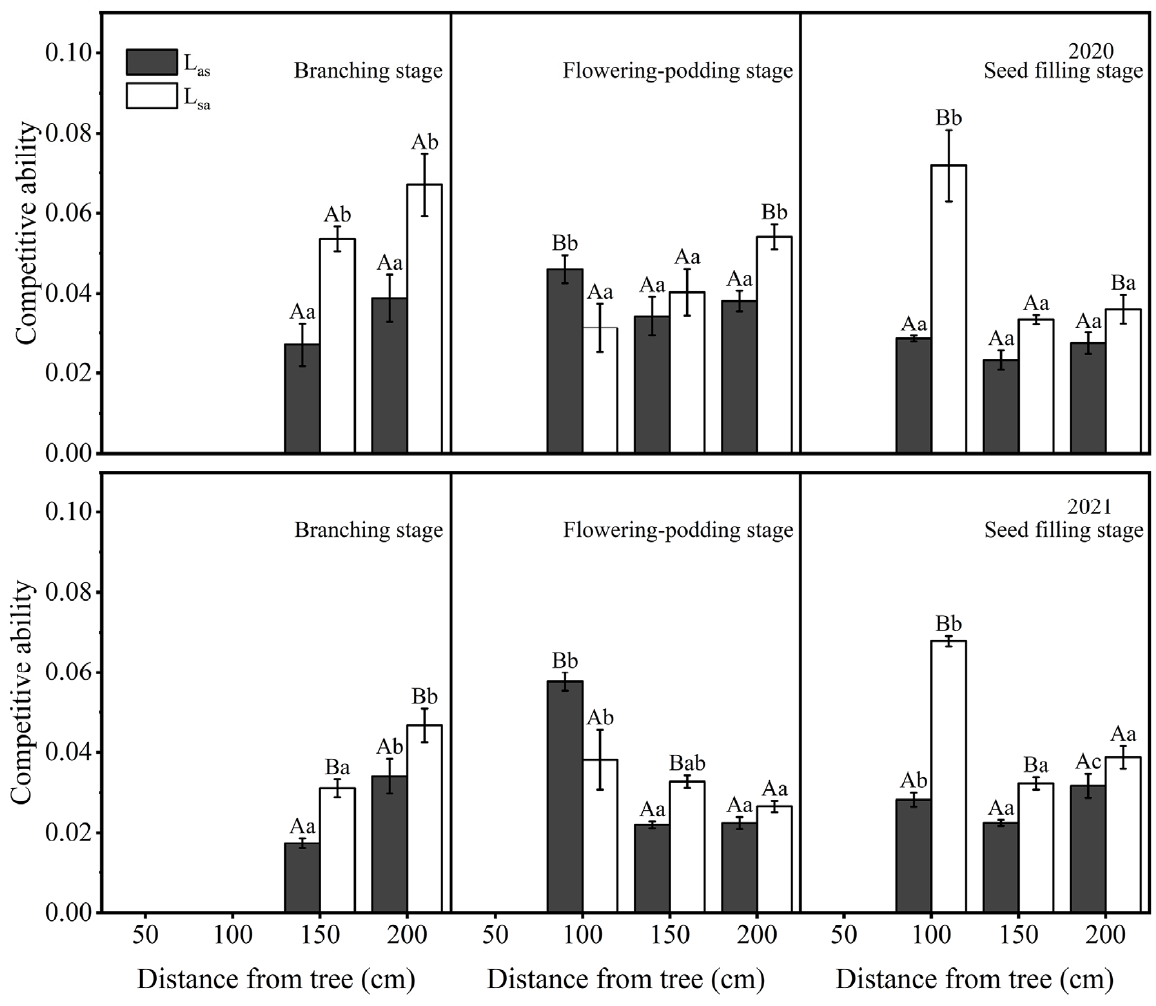
Figure 7. Competitiveness index of apple–soybean agroforestry system in the horizontal direction. L as : competitiveness index of apple to soybean; L sa : competitiveness index of soybean to apple. Lowercase letters indicate the significance analysis of different soil depths of the same species ( p < 0.05). Capital letters indicate the significance analysis of the same soil depth for different species ( p < 0.05).